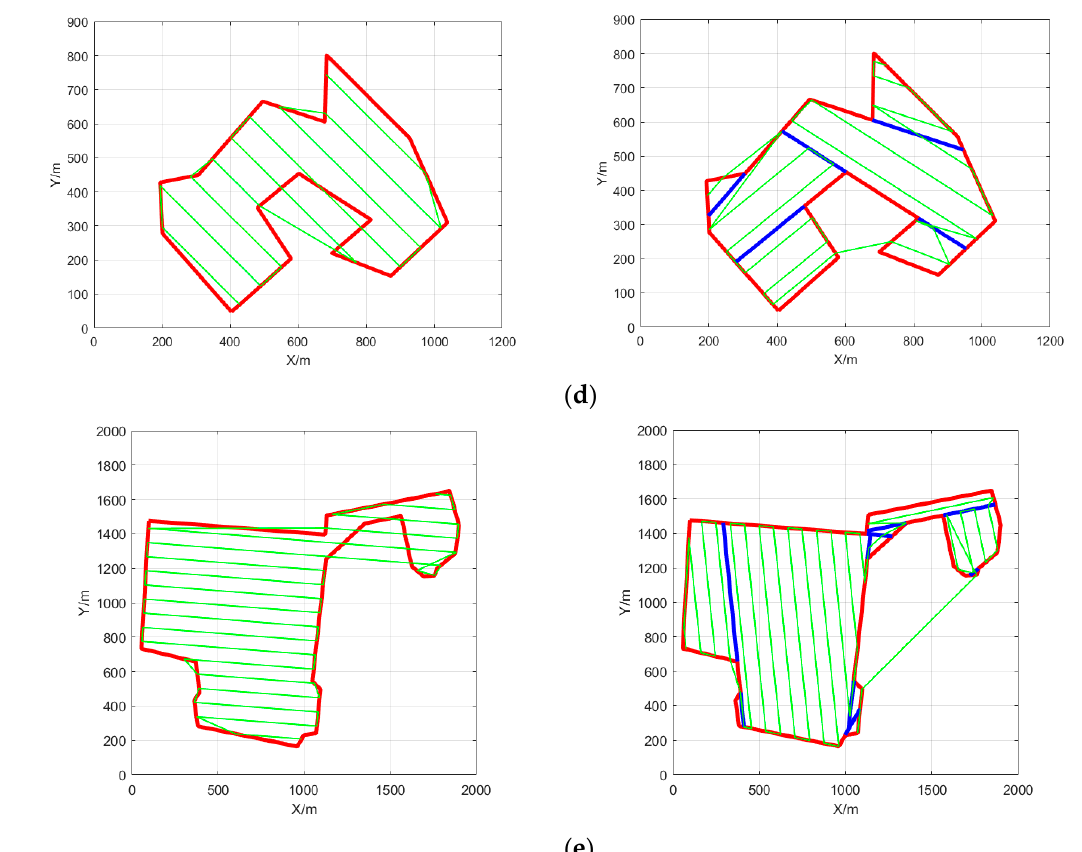
Figure 26. Coverage path of five areas before and after ROD. ( a ) Path comparison of area A; ( b ) path comparison of area B; ( c ) path comparison of area C; ( d ) path comparison of area D; ( e ) path comparison of area E.